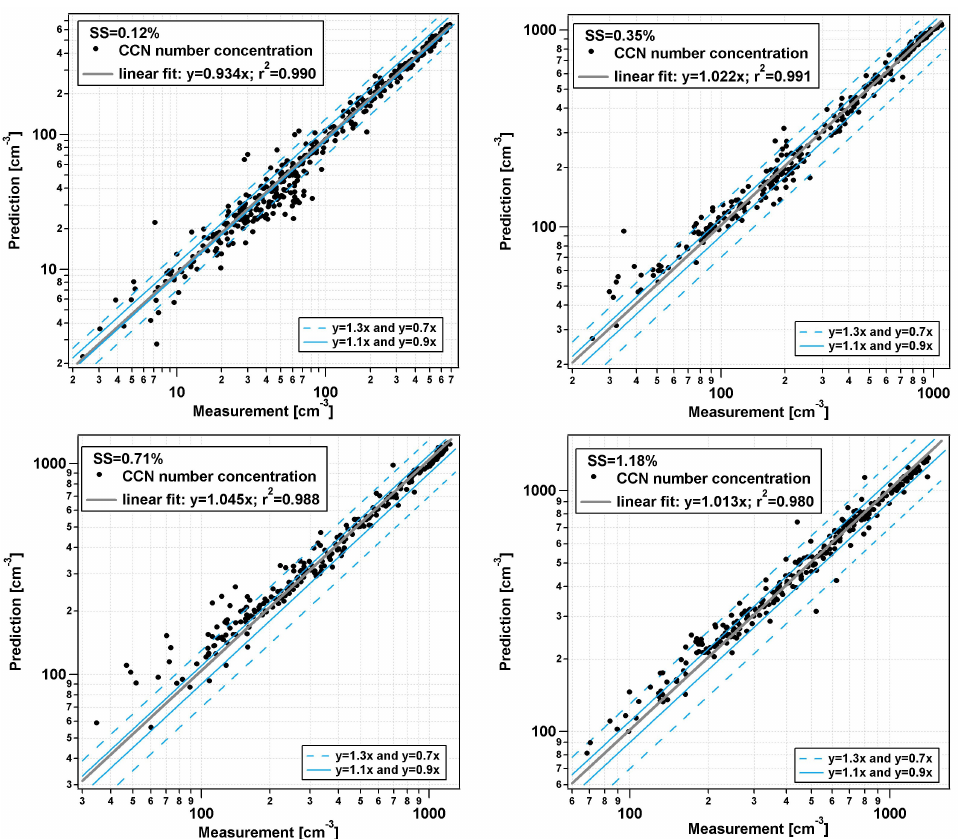
Fig. 4. Predicted vs. measured CCN number concentration for ambient aerosol at 4 different supersaturations using size distribution and chemical composition data. The grey line shows the fitted line through the data points. The method of the fit is explained in the text in details. The blue lines obey the y = 1 . 3 x, 1 . 1 x, 0 . 9 x, 0 . 7 x